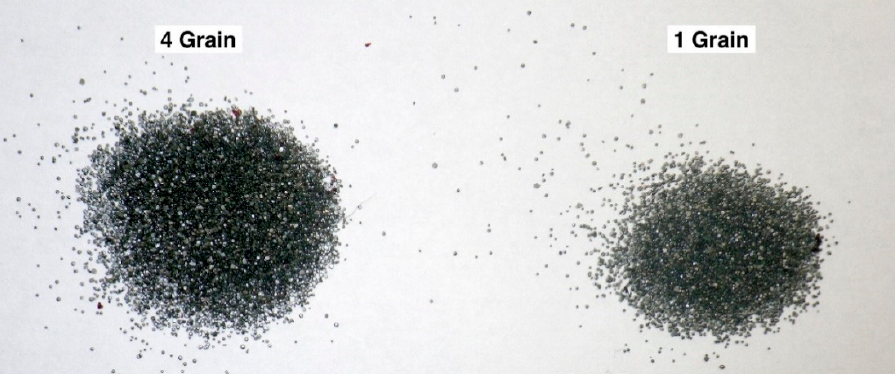
Figure 16. Cartridge contents comparison between a 4.00 grain and a 1.00 grain 0.22” calibre cartridge. Both cartridge cases are the same length and volume.